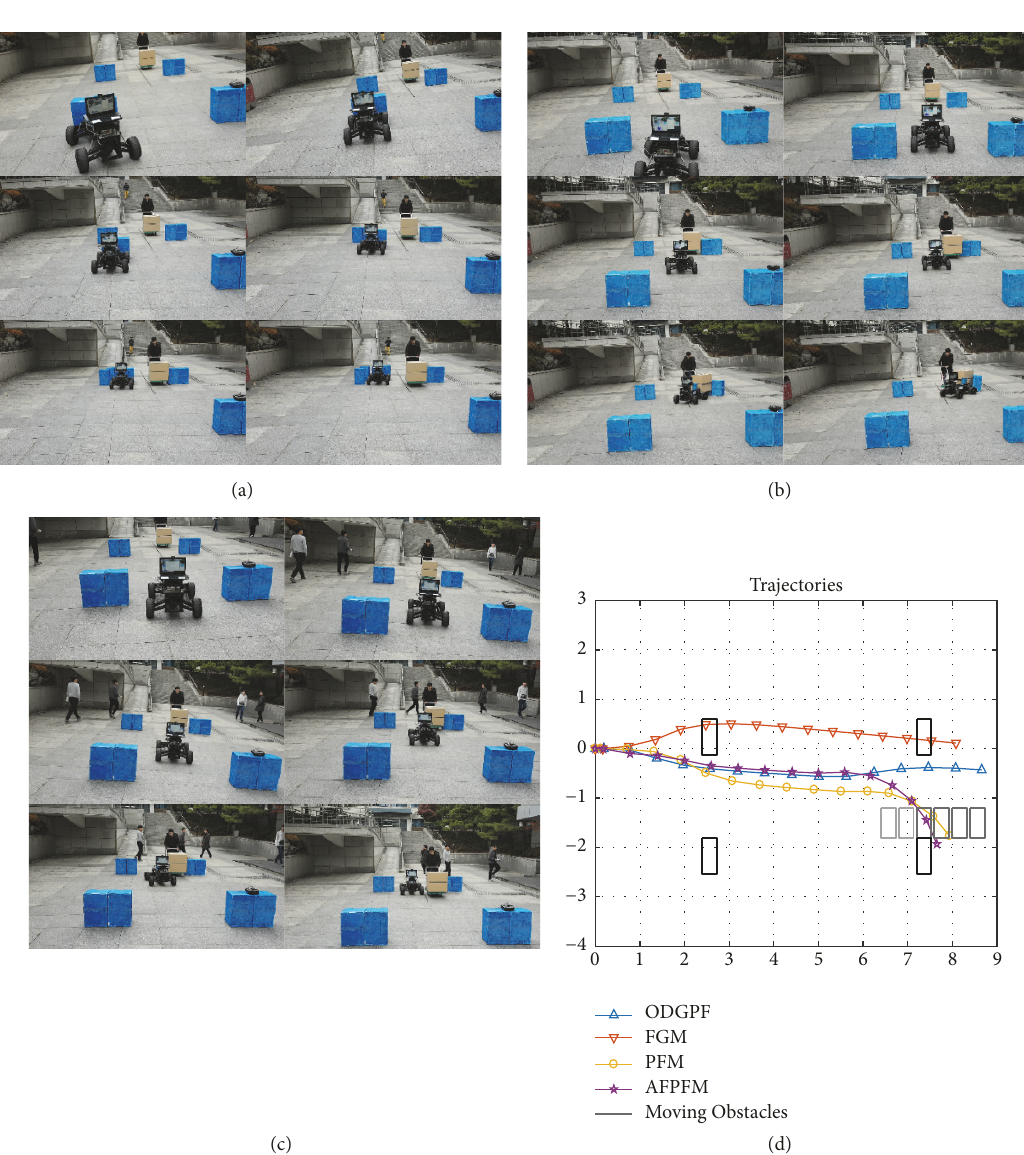
Figure 20: Experimental results for Scenario 3: (a) FGM, (b) AFPFM ( 𝑘 𝑎𝑡𝑡 =100), (c) ODG-PF, and (d)